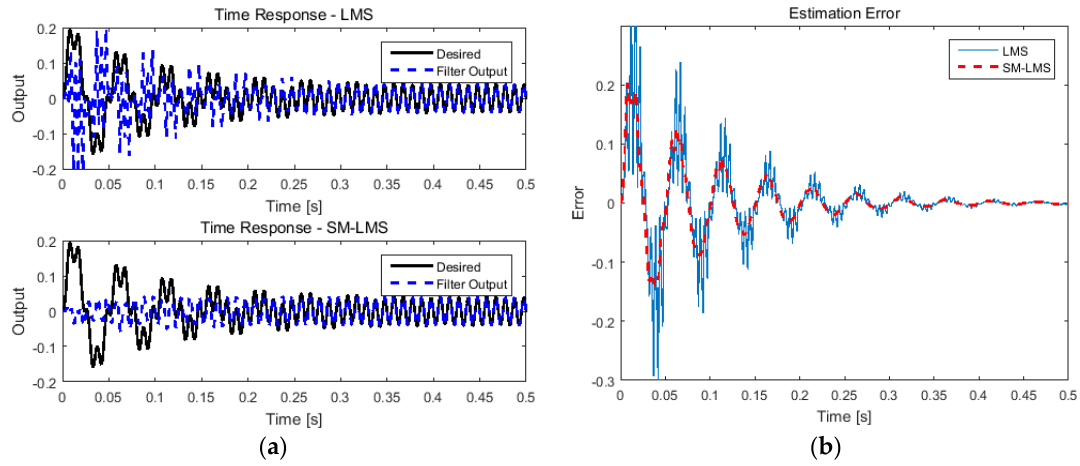
Figure 6. Control of a single sinusoid at 120 Hz in the time domain: ( a ) predicted with least mean squares and sliding mode least mean squares (Key: , original signal; , filter output); and ( b ) predicted estimation error (Key: , with least mean squares; , with sliding mode least mean squares).